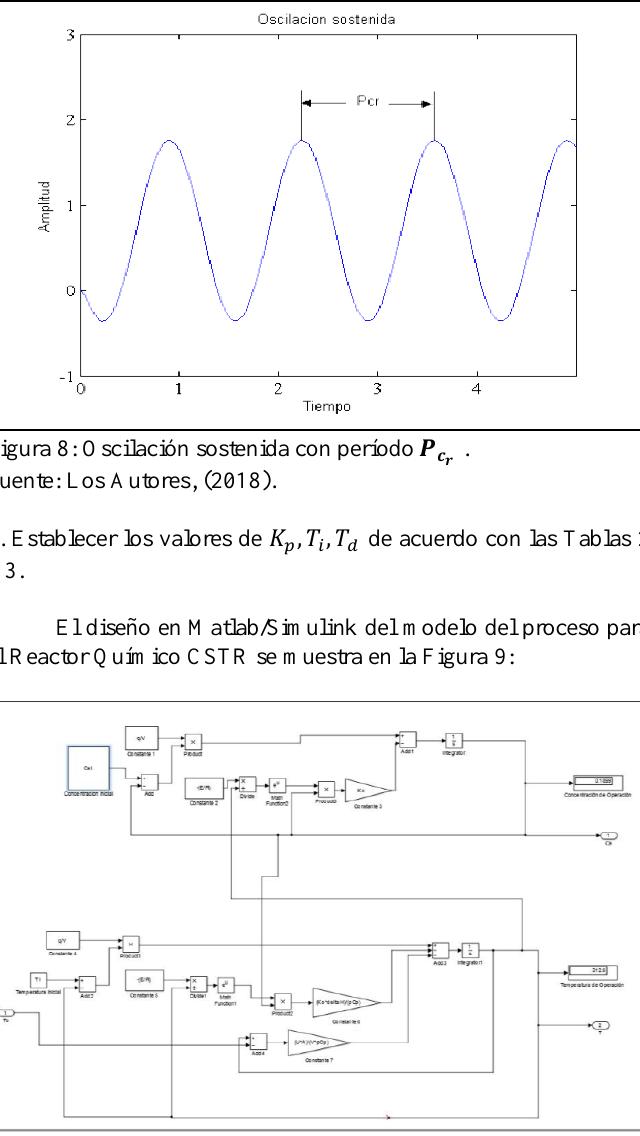
Figura 9: Modelo no lineal del Reactor Químico CSTR en Matlab/Simulink. Fuente: Los Autores, (2018).